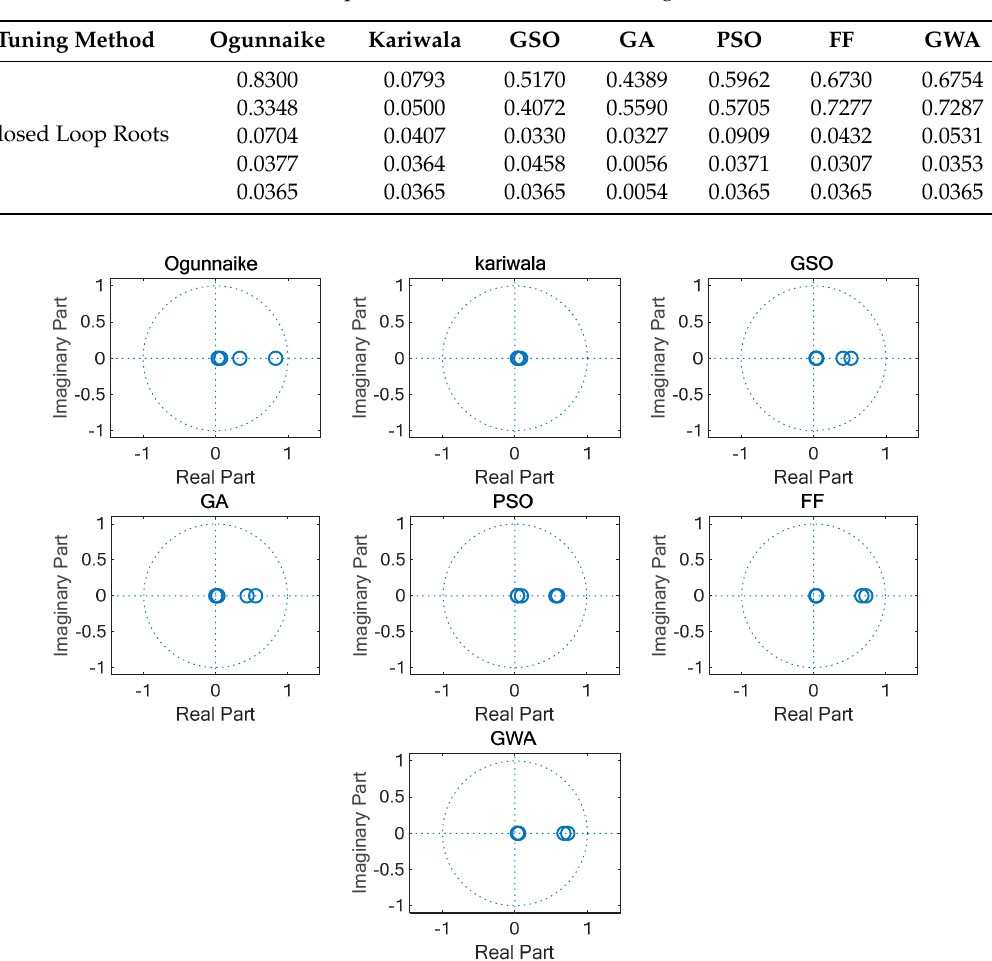
Figure 19. Example 1: z -plane plot for the roots of the characteristic equation.